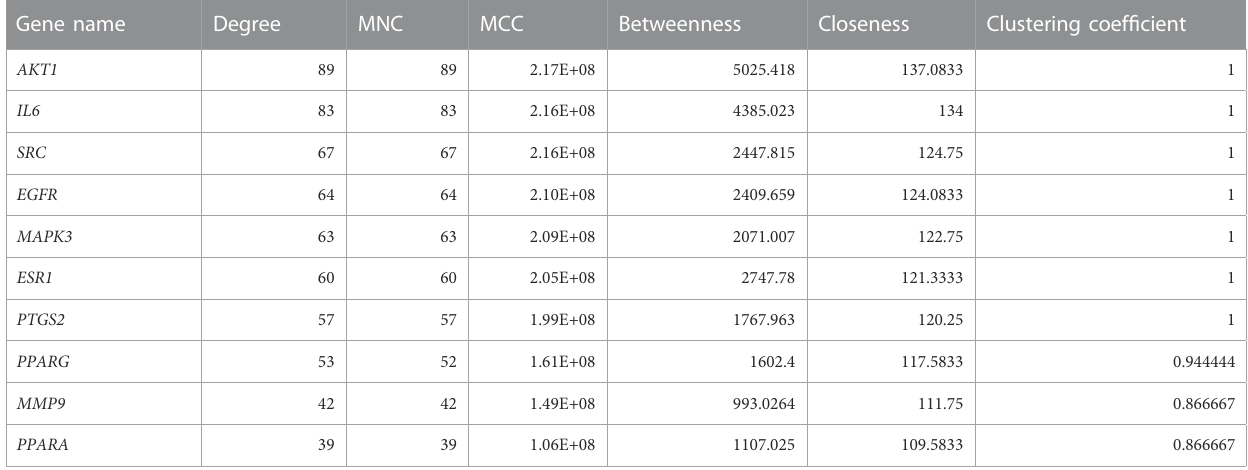
TABLE 3 Degree, MNC, MCC, betweenness, closeness, and clustering coef fi cient of top 10 hub